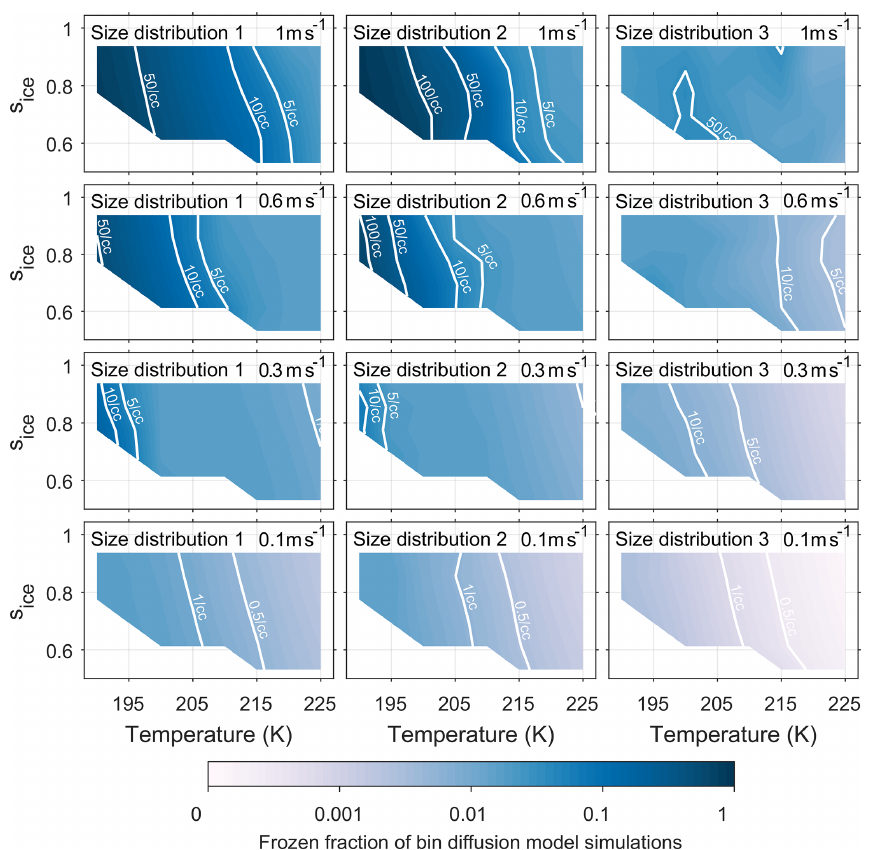
Figure A2. Quantifying the number of aerosol particles frozen in bin diffusion model simulations. The colour scale represents the frozen fraction of total aerosol particles and the labelled contour lines give the number of frozen aerosol particles per cubic centimetre. The model run have been initiated with three different size distributions, which are given in Fig. 2, and with constant updraft velocities ranging from 0.1 to 1ms − 1